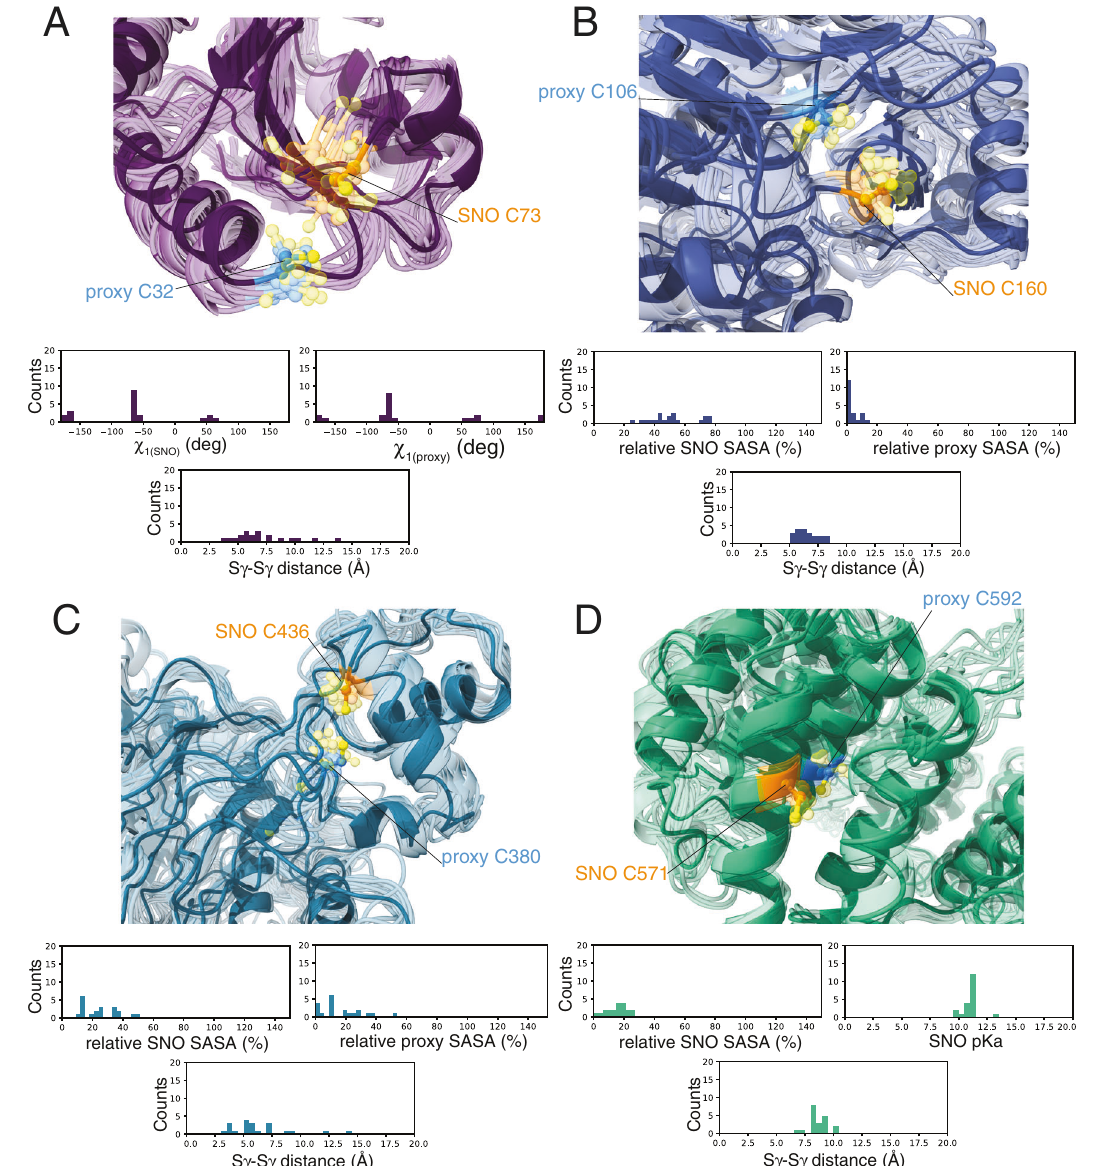
Fig. 7 S -nitrosylated cysteines can induce conformational changes in the proximal cysteines in different human proteins. To account for conformational changes of the SNO and proximal cysteines, we collected coarse-grained models of the 44 human proteins identi fi ed by the SNO fi nder pipeline (see Materials and Methods). A – D with subsequence all-atom reconstruction. The cartoons show the structural ensembles calculated for A thioredoxin (TXN, loop-loop class), B adenosine kinase (ADK, loop-strand class), C methionine aminopeptidase 2 (METAP2, helix- loop class), and D cullin-associated NEDD8-dissociated protein (CAND1, helix-helix class). The spheres indicate the atoms of the S- nitrosylated (SNO, orange) site and the proximal cysteine (proxy, blue). The distribution plots at the bottom of each panel show the values calculated in the coarse-grained models for i) χ 1(SNO) , χ 1(proxy) and S γ -S γ distance (panel A ), ii) relative solvent accessible surface area (SASA) of the SNO and proximal cysteines and S γ -S γ distance (panel B and C ), iii) χ 1(SNO) , pK a of the SNO cysteine and S γ -S γ distance (panel D ). We calculated these values using the SNOmodels pipeline (see Methods). We observe that during the simulations, the SNO site C32 of TXN (panel A ) and C160 of ADK (panel B ) can undergo conformational changes and explore more solvent-accessible conformations, with S γ -S γ distances mainly in the range of 3 – 7.5 Å and 5 – 8 Å, respectively. Furthermore, the SNO sites and proximal cysteines of TXN seem to prefer the minus state for their χ 1 dihedrals. The proximal C380 of METAP2 (panel C ) is on a highly dynamic loop and assumes different orientations. On the other hand, the two cysteines of CAND1 (panel D ) are in α -helices that constrain their positions, with S γ -S γ distances larger than 7.5 Å. mechanisms of its redox modi fi cation. The two cysteines (C373 cause misfolding. This is an interesting case study to address the and C347) are located on two fl exible loops, and their sulfur atoms interplay between S- nitrosylation and propensity for proteasomal can get as close as 2 Å (Table S3). degradation or other clearance mechanisms of misfolded proteins, We found three cases classi fi ed as loop-helix , i.e., GRIN2A, similar to what was observed for the S- nitrosylated variant of NUMA1, and CSRP1 (Fig. 6C). NUMA1 is one example of a loop- TRAP1 [7]. Moreover, S- nitrosylated XIAP has been detected in the helix class where the SNO site (C80) is on a long disordered loop, brain of patients with neurodegenerative disorders [51], empha- while the proximal C65 is located on an α -helix. sizing the importance of deciphering the underlying structural Cell Death and Disease (2023)